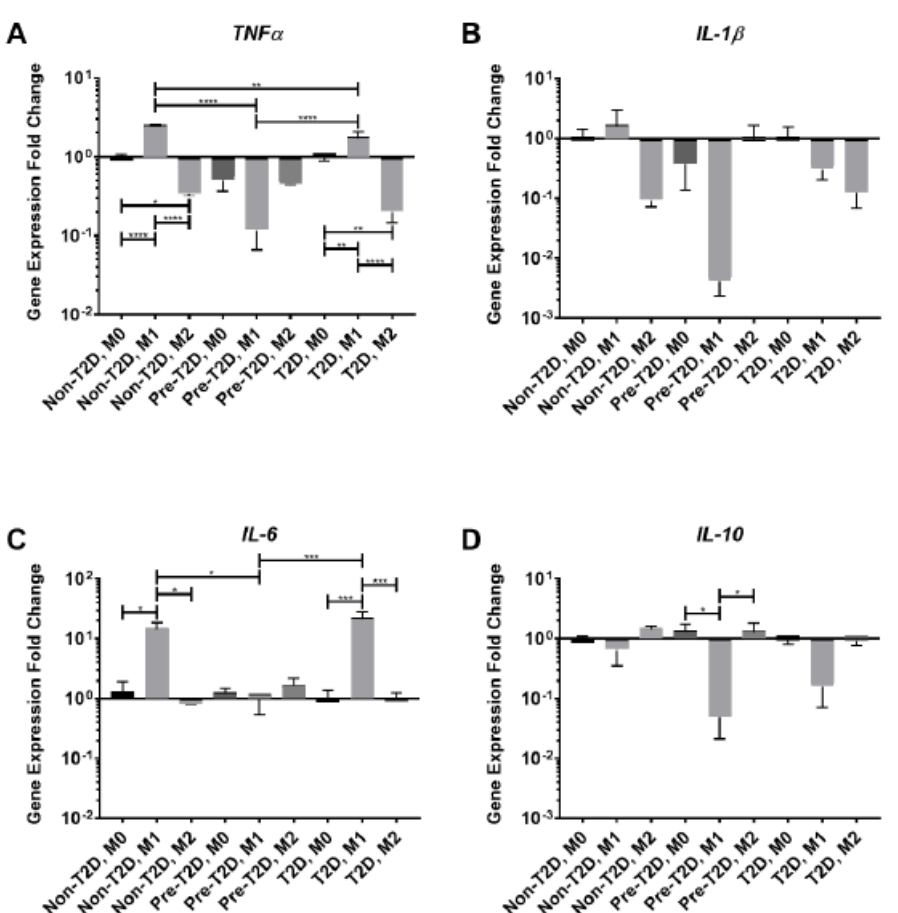
Figure 5. Decreased TNF α and IL-6 expression by M1 macrophages after co-culture with Pre-T2D IPFP-ASCs. ( A – D ) Macrophage mRNA expression determined by RT-qPCR ( n = 3, * p < 0.05, ** p < 0.01, *** p < 0.001, **** p < 0.0001). Control Group: M0 Macrophages Co-cultured with Non-T2D-IPFP ASCsNon-T2D: Non-Type II diabetes mellitus, Pre-T2D: Pre-Type II diabetes mellitus, T2D: Type II diabetes mellitus.